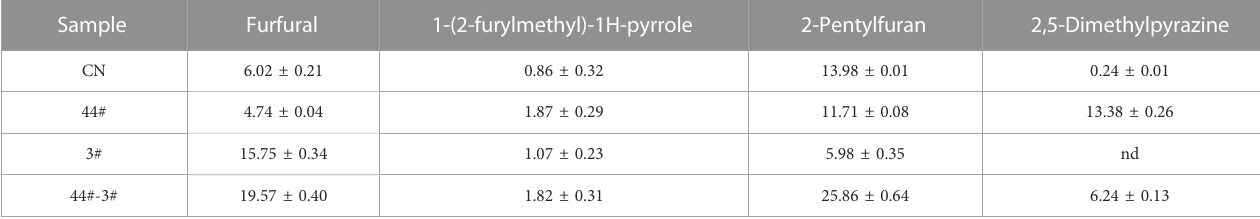
TABLE 8 Main differential fl avor compounds content of combination of strains 4# and 3# (ug/g). Sample